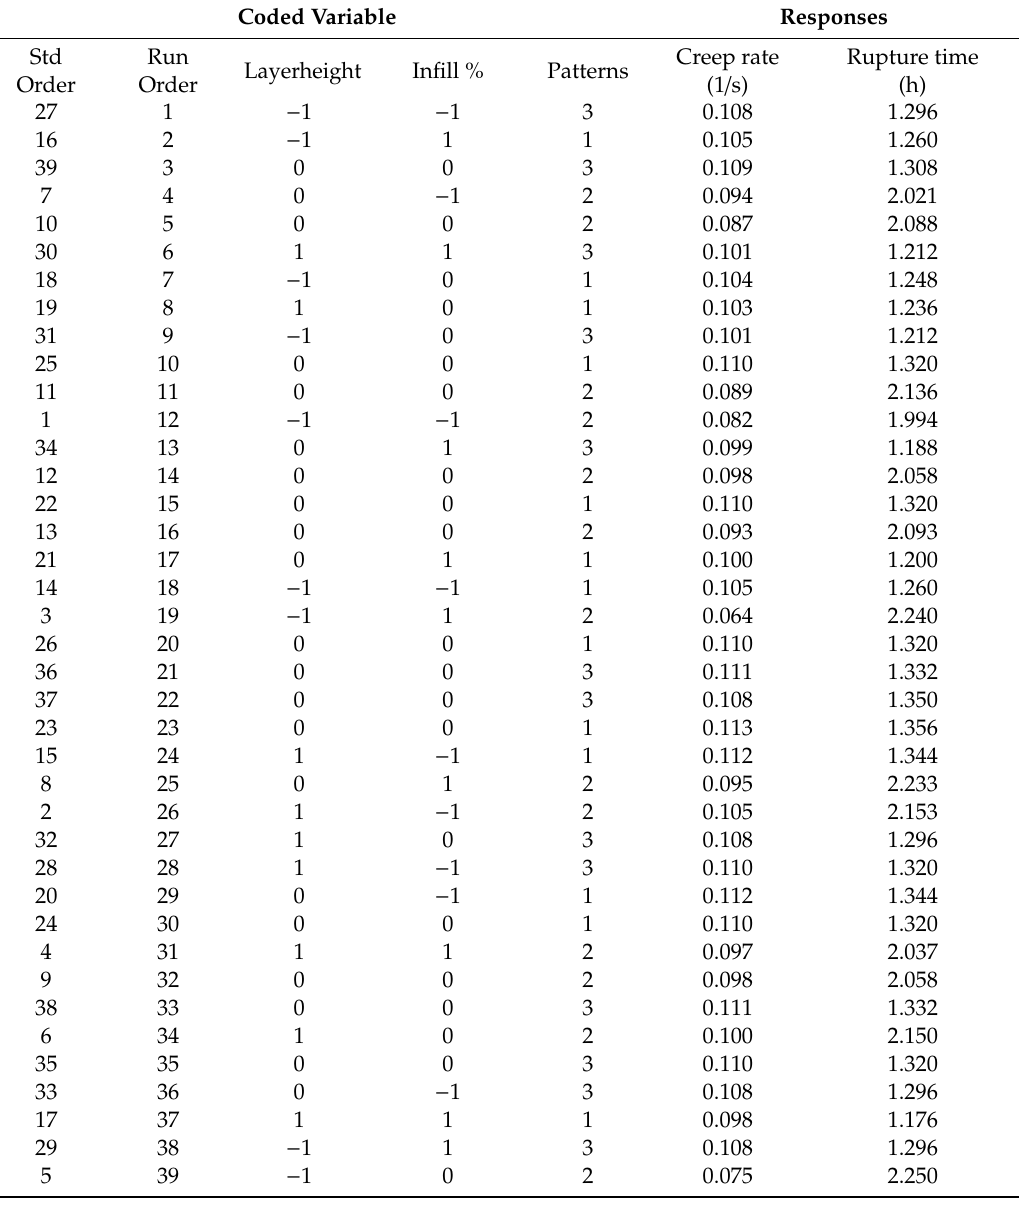
Table 3. Categorical Central Composite Design (CCD) matrix and measured responses.